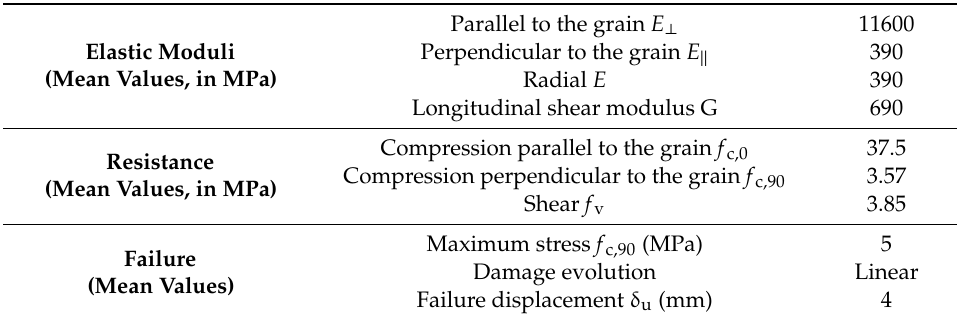
Table 1. Input mechanical properties for GL24h strength class timber (ABAQUS /